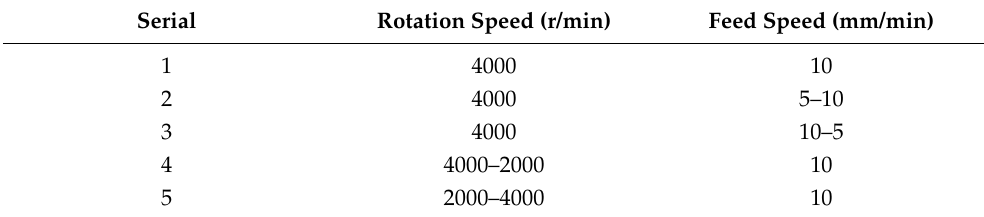
Table 2. Variable parameter drilling design matrix.